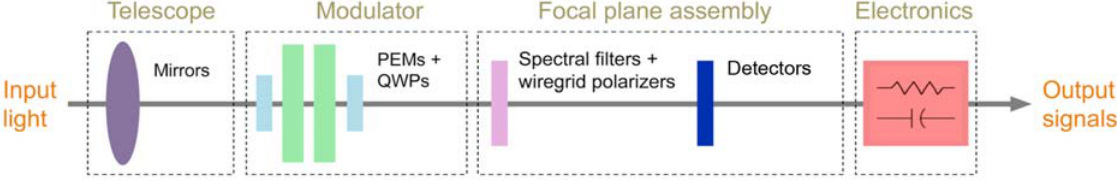
Figure 1. The main elements of the Multiangle SpectroPolarimetric Imager (MSPI) polarimetric imaging approach are the telescope, the dual- photoelastic modulator (PEM) retardance modulator, the focal plane assembly, and